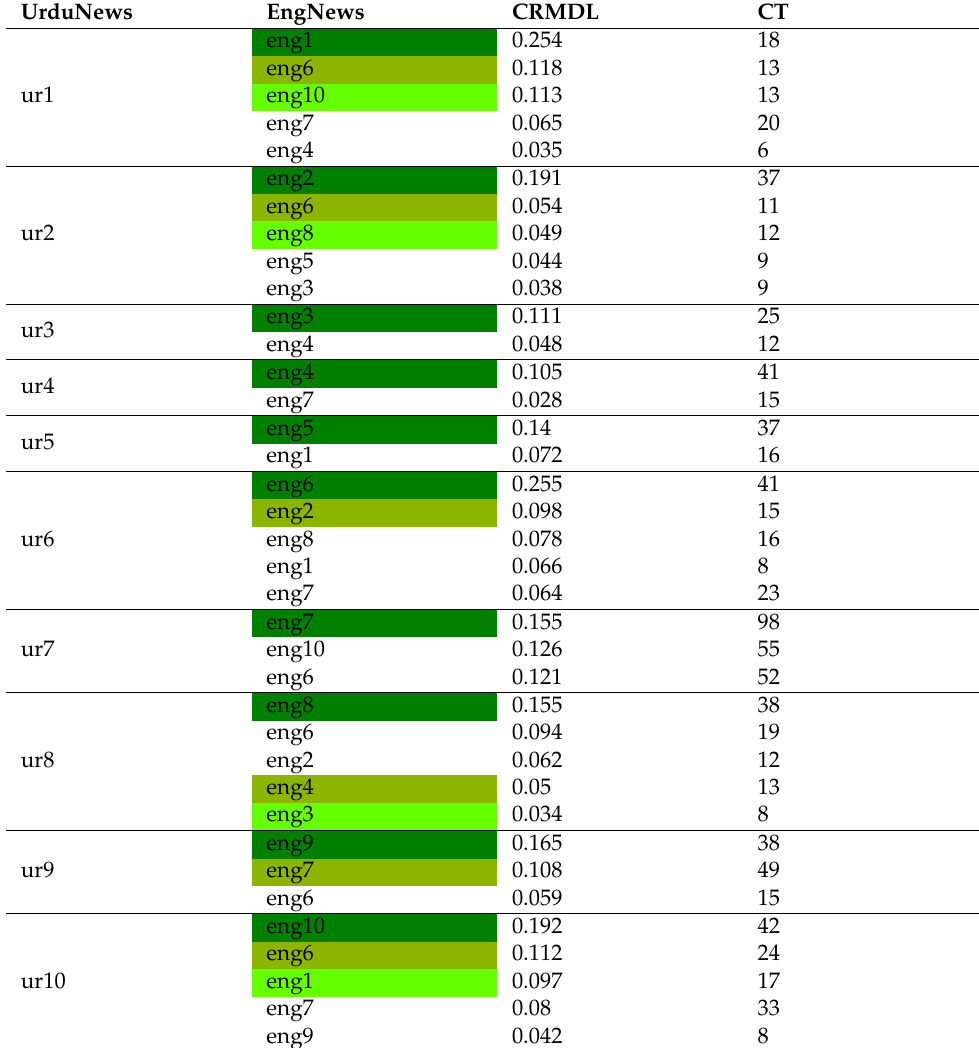
Table 6. Computed Similarity for 20 News Articles using